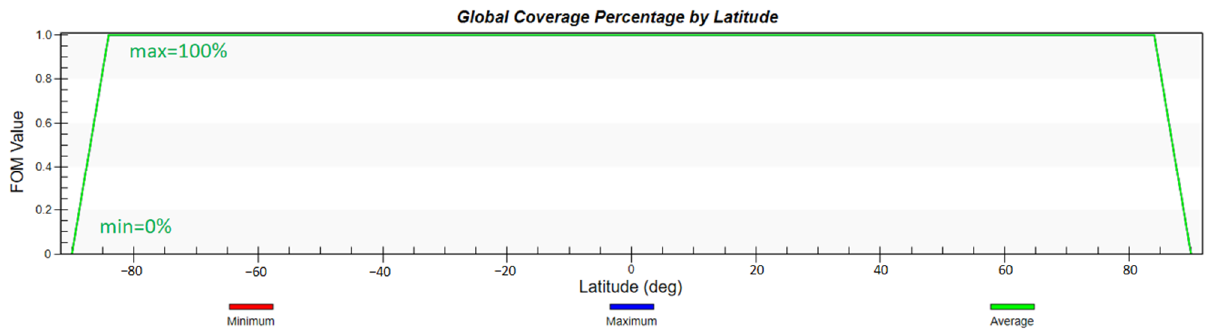
Figure 7. Global coverage percentage by latitude.